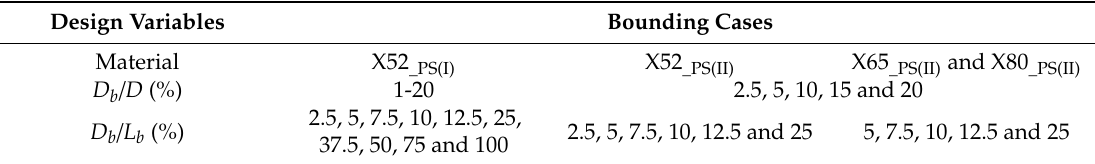
Table 3. Variables for the FEA based parametric